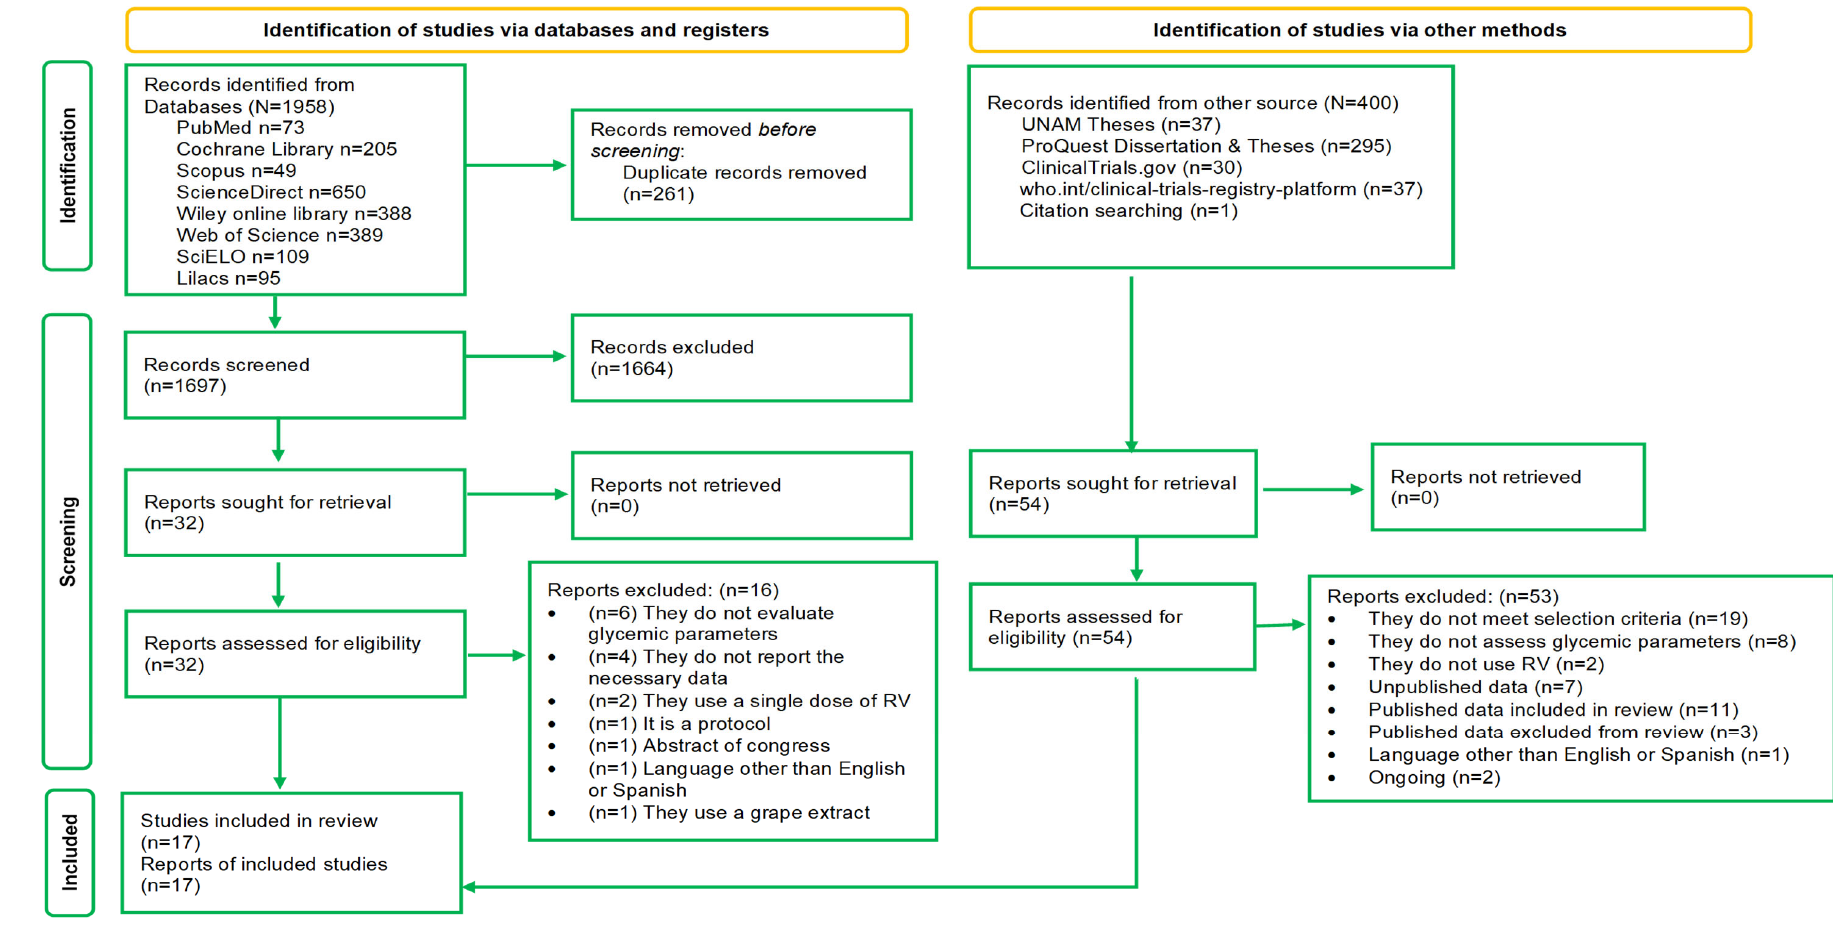
Figure 1. Study selection flow chart.